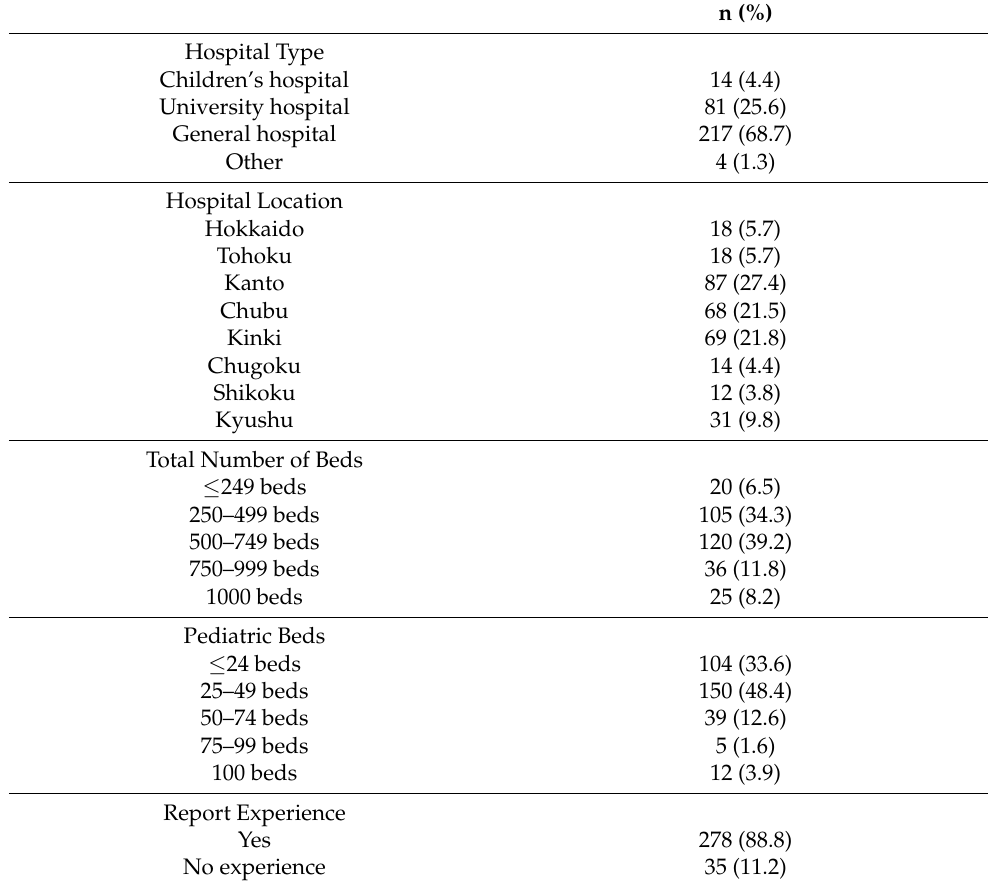
Table 1. Basic attributes of responding facilities (n = 318).